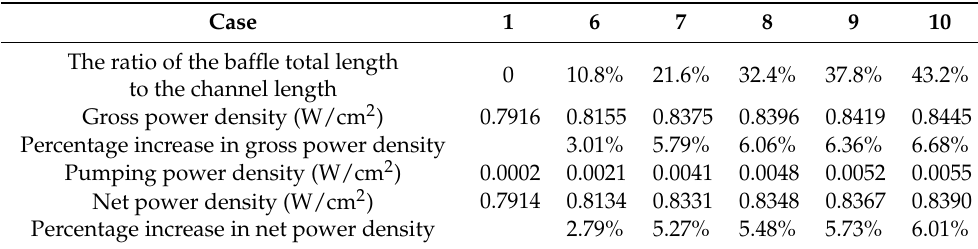
Table 7. Cases performance under different total dimensionless lengths of baffles.